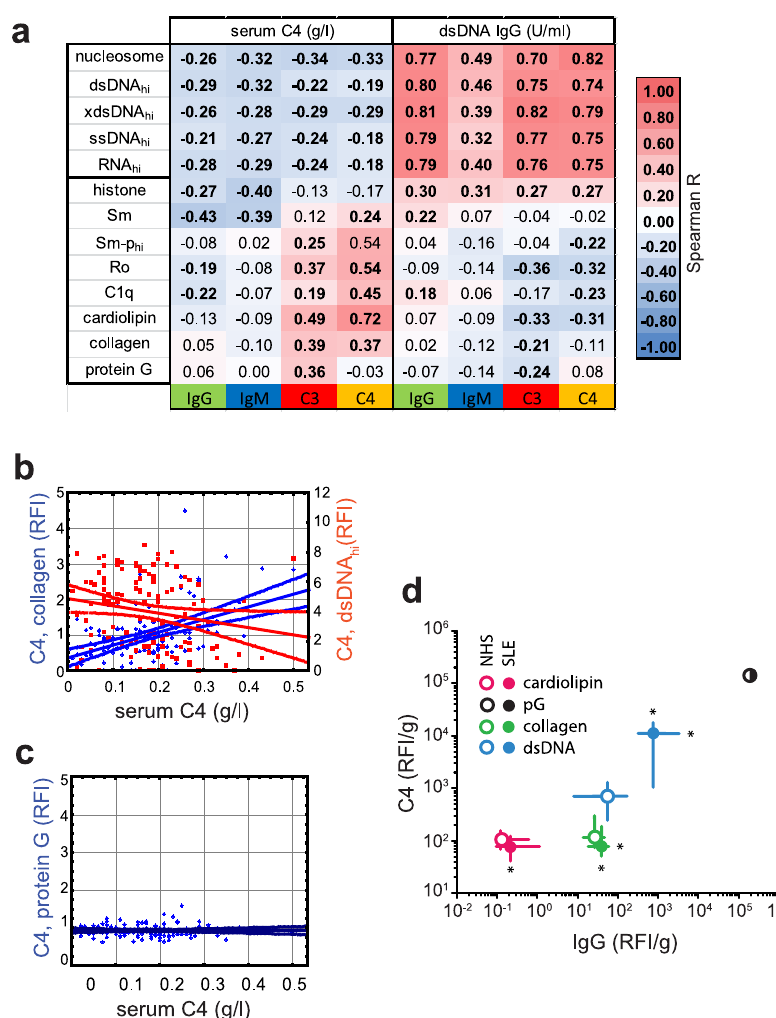
Fig 3. Opposite complement activating properties of biochemically different antigens in SLE. The PECS SLE cohort with available serum complement concentrations (n = 124) was analyzed for associations between serum protein levels and on-chip antigen binding of immunoglobulin and complement proteins. a Spearman rank-correlations of serum C4 concentrations, dsDNA IgG reactivity with various microarray derived binding data. Values indicate r, bold fonts highlight significant correlations (p < 0.05). b Comparative C4 deposition on dsDNA and collagen as a function of serum C4 concentrations. Linear regression fits with 95% confidence intervals are shown. c Complement C4 deposition initiated by superantigen protein G as a function of serum C4 concentration. d Comparative C4 deposition and IgG binding on various antigens on a mass basis in healthy and SLE serum samples. Asterisks indicate direction and significance (p < 0.05) of changes in the SLE versus NHS group. pG, Staphylococcal protein